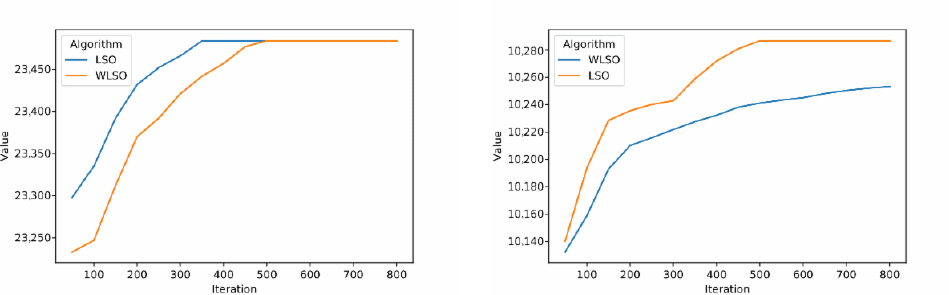
Figure 3. LSO and WLSO Convergence average chart for 100-5-2-0-2 and 100-5-2-1-0